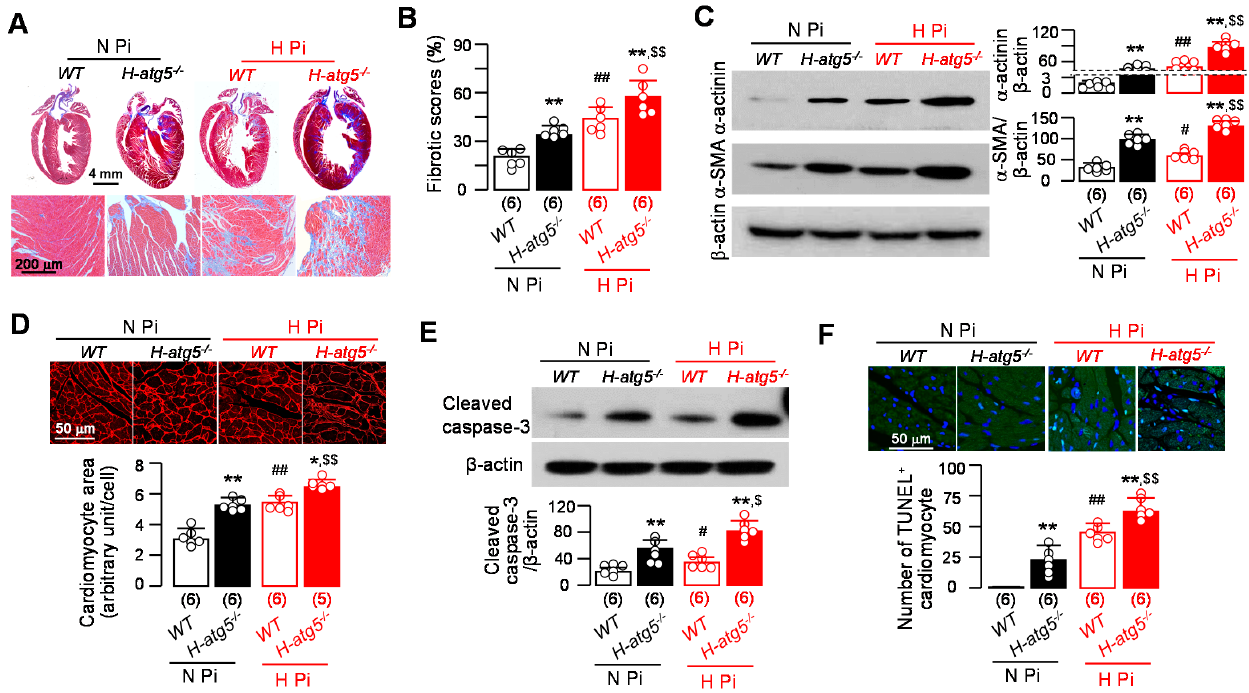
Figure 5. High phosphate exacerbated pathological cardiac remodeling in H-atg5 -/ - mice. WT mice or H-atg5 -/- mice were fed with normal- or high-phosphate diet starting at 3 months old for 12 weeks. ( A ) Representative macrographs (upper panel) and micrographs (bottom panel) of sagittal TC-stained sections of the hearts. ( B ) Semi-quantification of the TC-positive area over the whole-heart section with Image J. ( C ) Changes in hypertrophic and fibrotic markers in the heart. Left panel: representative immunoblots of left ventricular lysates for α -actinin and α -SMA protein. Right panel: a summary of all immunoblot data. ( D ) Hypertrophic cardiomyocytes in free walls of left ventricles of mice. Upper panel: representative immunohistochemistry for WGA. Bottom panel: semi-quantification of myocyte size with Image J. ( E ) The changes in apoptotic markers in the heart. Upper panel: representative immunoblots for cleaved caspase-3 in left ventricular lysates. Bottom panel: a summary of immunoblot data. ( F ) Changes in apoptotic markers in the heart. Upper panel: representative immunofluorescent images for TUNEL in free wall of left ventricles. Bottom panel: semi-quantification of TUNEL-positive cells/DAPI-positive cardiomyocytes. Sample number in each group is presented in brackets underneath corresponding bars. Quantitative data are presented as mean ± SD with scatter plots of individual data points. * p < 0.05, ** p < 0.01 vs. WT mice at the same dietary phosphate treatment; # p < 0.05, ## p < 0.01 vs. WT treated with normal-phosphate diet; $ p < 0.05, $$ p < 0.01 vs. H-atg5 -/- mice treated with normal-phosphate diet. Statistical significance was assessed by two-way